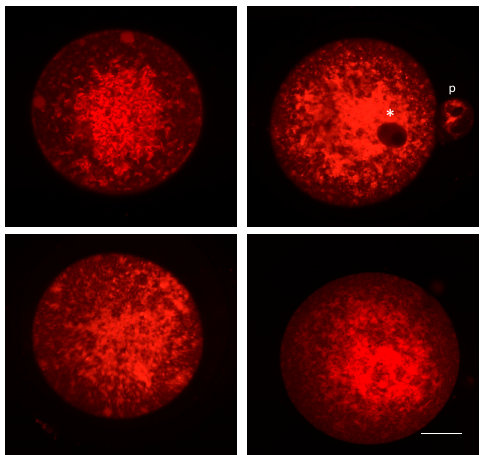
Figure 1. Confocal photomicrographs of mitochondrial distribution patterns in mouse oocytes. Oocytes collected from adult female mice following hormone stimulation-induced superovulation were classified as metaphase-II (extruded first polar body), and then incubated with MitoTracker Red (Thermo Fisher Scientific, Waltham, MA). Oocytes were immediately coverslipped and imaged using a Zeiss laser scanning confocal microscope. Mitochondria are noticeably punctate and present throughout the oocyte. Examples demonstrate multiple focal planes, with perinuclear distribution (indicated by white asterisk), and a polar body (p) is visible in the top right panel. Scale bar = 15 µm.